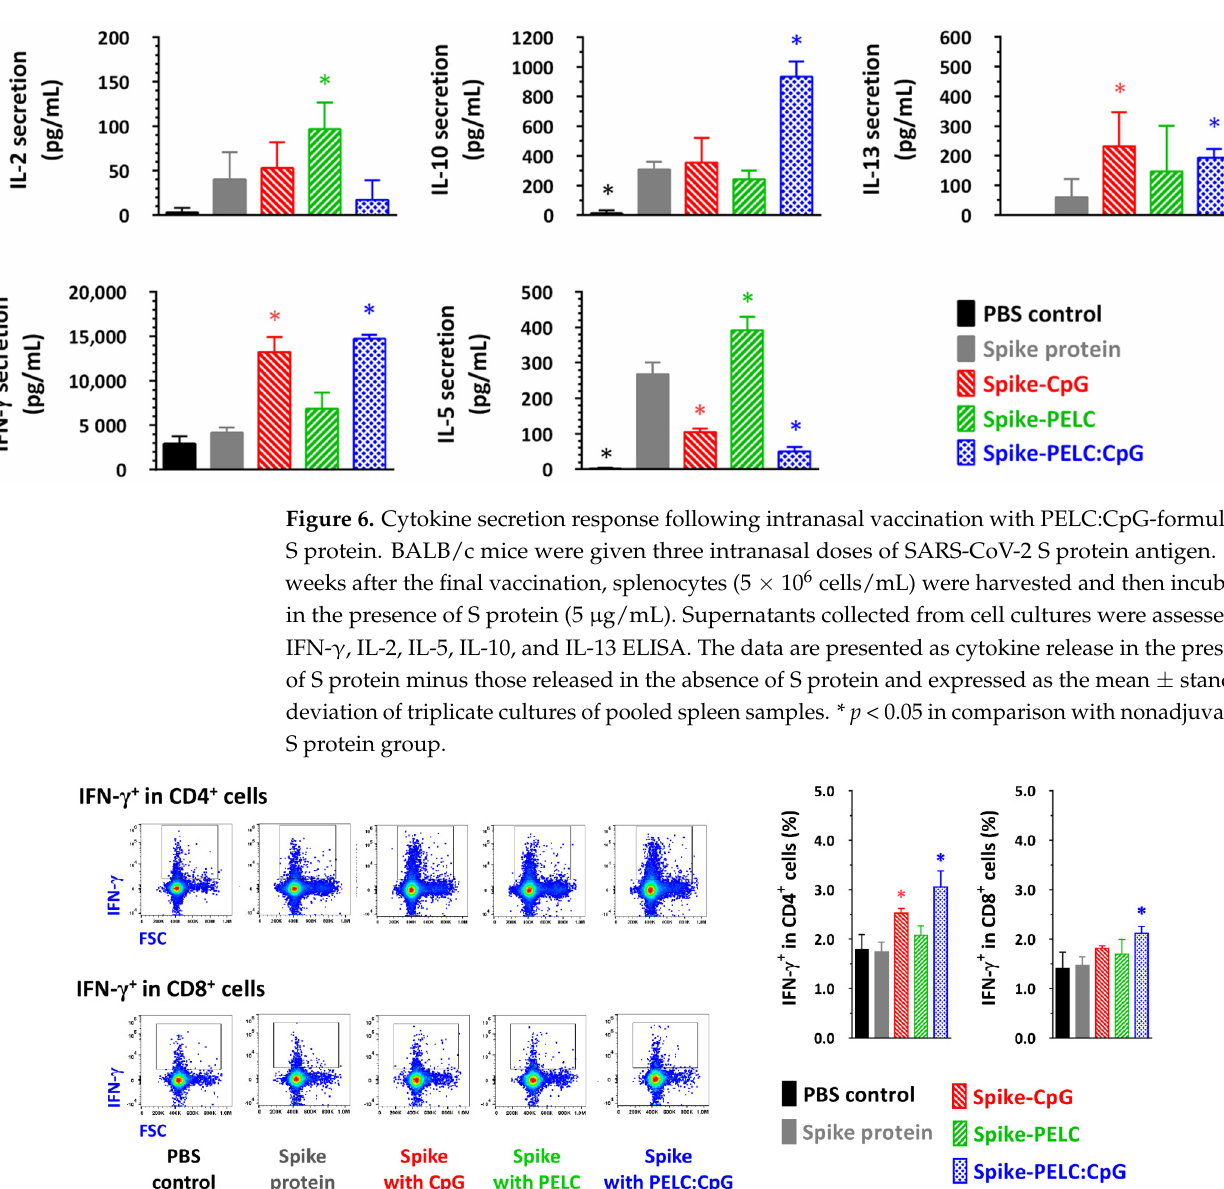
Figure 7. IFN- γ -secreting cells in antigen-specific CD4 + /CD8 + T cells following intranasal vaccination with PELC:CpG-formulated S protein. BALB/c mice were given three intranasal doses of SARS-CoV-2 S protein antigen. Two weeks after the final vaccination, the mice were sacrificed, and splenocytes (5 × 10 6 cells/mL) were harvested and then incubated with S protein (5 μ g/mL) for 24 h. Splenic CD19-excluded CD3 + cells were analyzed by flow cytometry to determine the levels of IFN- γ expression in CD4 + or CD8 + cells. The positive population percentage data within the rectangle gates are represented as the mean ± standard deviation from triplicate cultures of pool murine spleen samples. * p < 0.05 in comparison with nonadjuvanted S protein group.